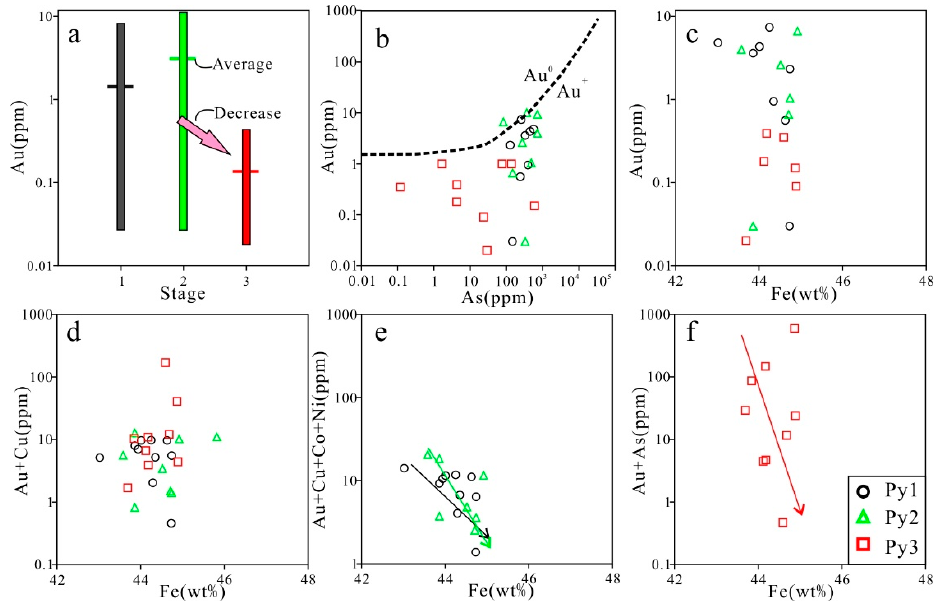
Figure 9. Time-resolved analytical signals of a LA-ICP-MS analysis from Au-bearing pyrite. Suspected solid inclusions are characterized by high Zn ( a ) and Pb intensities ( b ) (cps: counts-per-second).